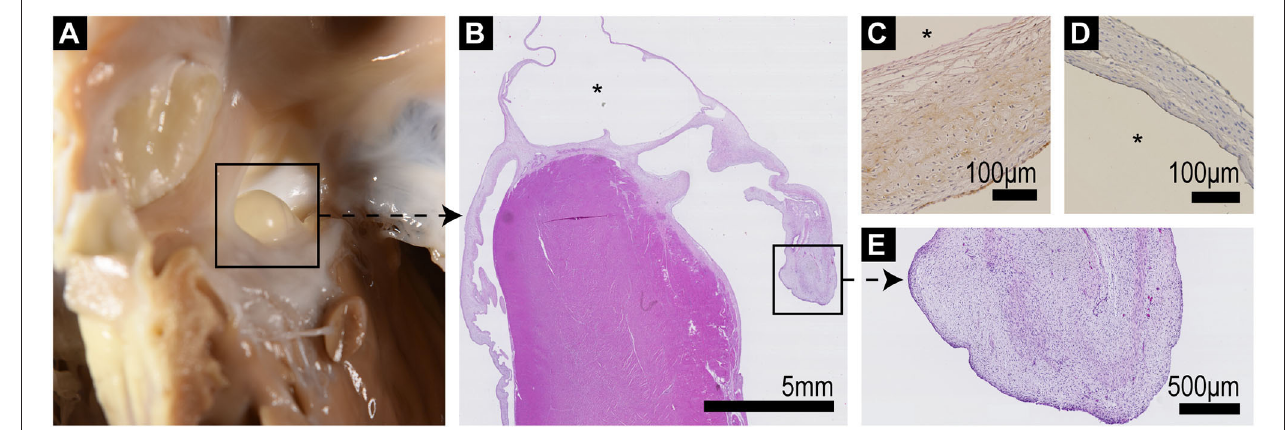
FIGURE 4 | (A) Septum with ASD and protruding serous cyst as viewed from the right ventricle. (B) Low power (10x) histological overview of a longitudinal section through the interventricular septum including the cyst (*) which bridges the septum and atrioventricular valves; the left AV valve is to the right of the image, exhibiting marked thickening and distortion of the valve leaflet particularly at its tip. (C) FXIIIra/vWF staining shows positive staining of the outer aspect of the cyst wall, which corresponds to the endocardial valve surface, with negative staining of the inner (*) lining. (D) CD31 (pan-endothelial marker) staining shows positive staining of